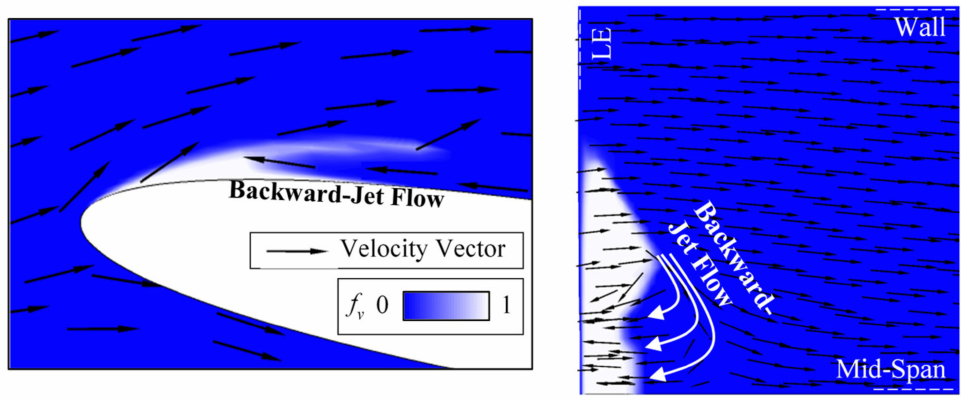
Figure 13. Indication of the backward-jet flow breaking the attached cavity at low C σ . LE: leading-edge. For the total length of the attached part of cavity on mid-span l cav* , the growth rate is similar to l cav . From C σ = 2.713 to C σ = 1.480, the value of d( l cav* /c )/d C σ is lower than 0.2. The value of l cav * increases from about 0.019 to 0.162. From C σ = 1.480 to C σ = 1.071,